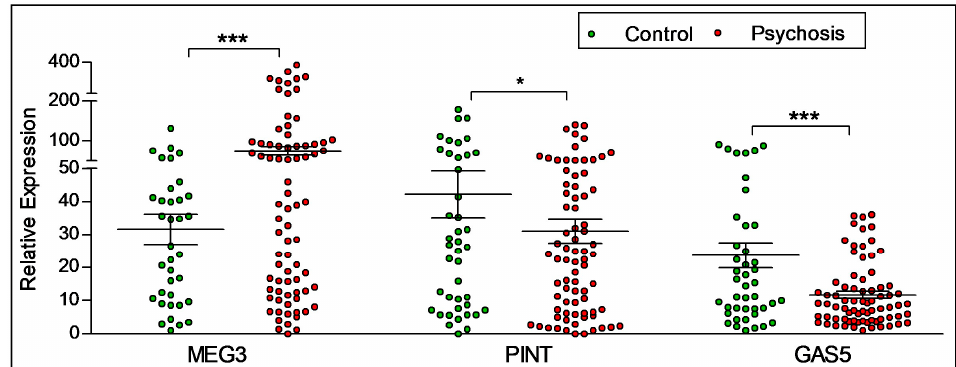
Figure 2. Diagnostic difference in the expression of lncRNAs. A difference in the expression of lncRNAs MEG3, PINT and GAS-5 was seen between control participants and participants with